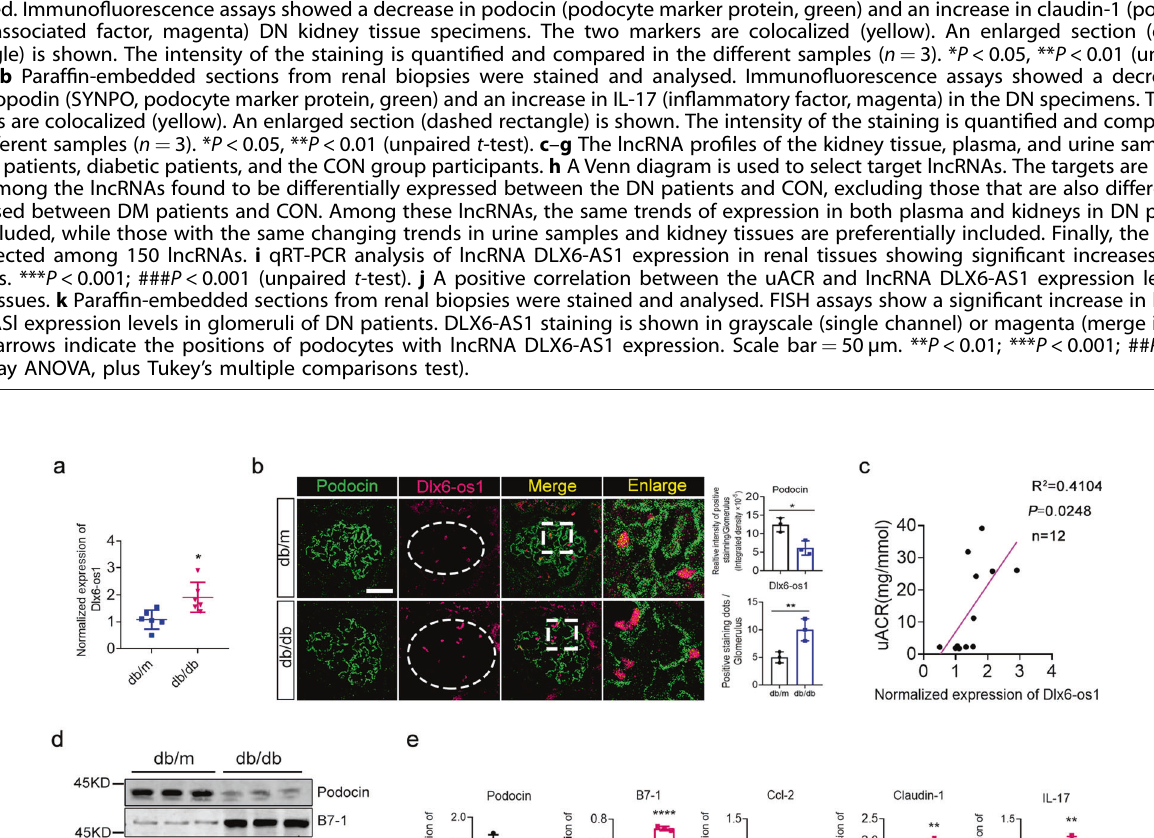
Fig. 1 The expression pro fi les of lncRNAs in the kidney tissue, plasma, and urine samples of diabetic nephropathy (DN) patients, diabetes mellitus (DM) patients, and normal healthy controls (CON). a Paraf fi n-embedded sections from renal biopsies were stained and analysed. Immuno fl uorescence assays showed a decrease in podocin (podocyte marker protein, green) and an increase in claudin-1 (podocyte injury-associated factor, magenta) DN kidney tissue specimens. The two markers are colocalized (yellow). An enlarged section (dashed rectangle) is shown. The intensity of the staining is quanti fi ed and compared in the different samples ( n = 3). * P < 0.05, ** P < 0.01 (unpaired t -test). b Paraf fi n-embedded sections from renal biopsies were stained and analysed. Immuno fl uorescence assays showed a decrease in synaptopodin (SYNPO, podocyte marker protein, green) and an increase in IL-17 (in fl ammatory factor, magenta) in the DN specimens. The two markers are colocalized (yellow). An enlarged section (dashed rectangle) is shown. The intensity of the staining is quanti fi ed and compared in the different samples ( n = 3). * P < 0.05, ** P < 0.01 (unpaired t -test). c – g The lncRNA pro fi les of the kidney tissue, plasma, and urine samples of the DN patients, diabetic patients, and the CON group participants. h A Venn diagram is used to select target lncRNAs. The targets are chosen